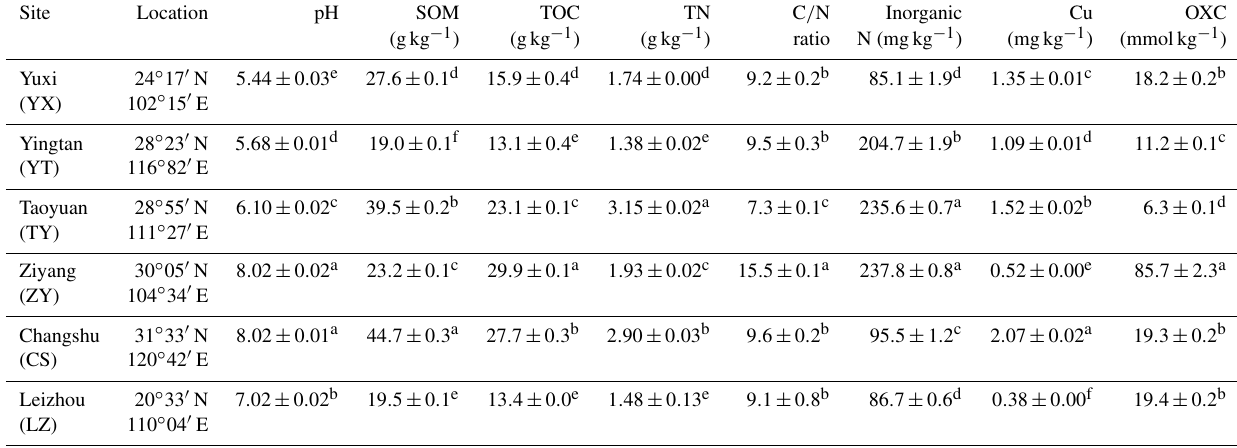
Table 1. The sampling locations and chemical characteristics of the rice paddy soils. Site